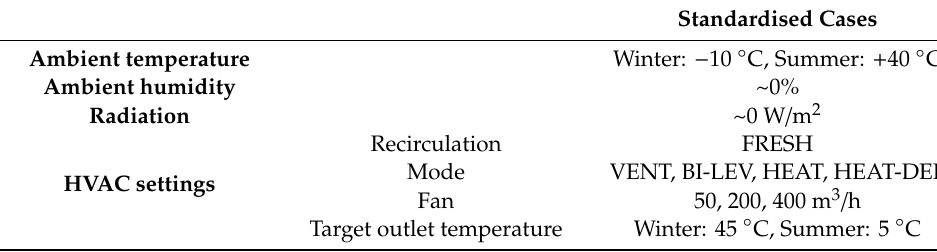
Table 1. Standardised heating and cooling cases for the 1D thermal and comfort model.